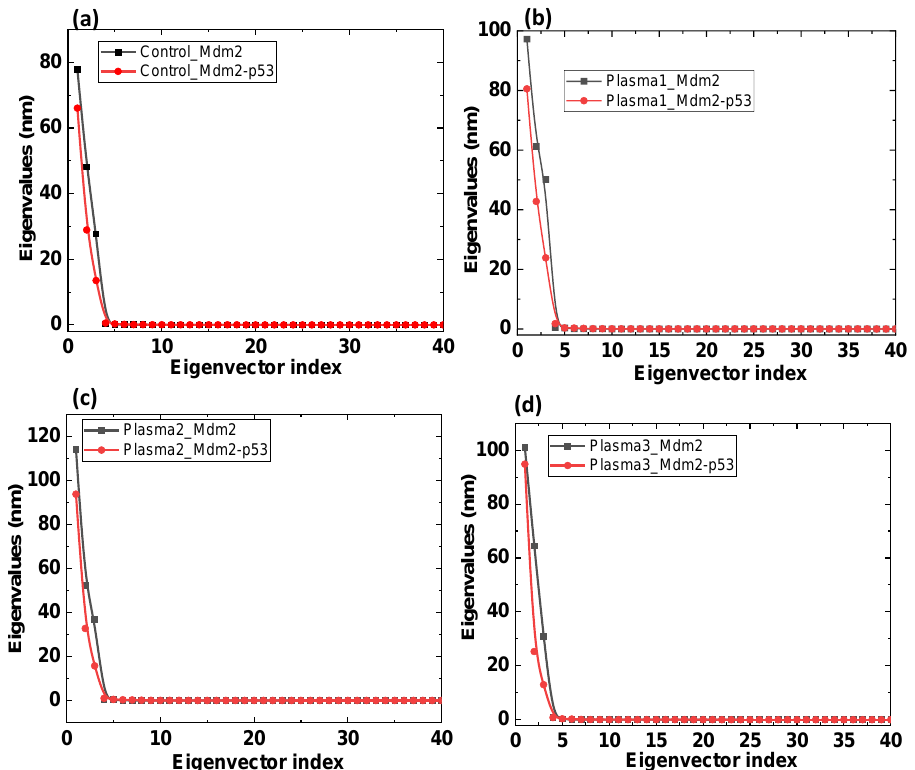
Figure 6. Comparison of the eigenvalues plotted against the corresponding eigenvector indices obtained from the C α covariance matrix for ( a ) control Mdm2 and Mdm2–p53 complex, ( b ) plasma1 Mdm2 and Mdm2–p53 complex, ( c ) plasma2 Mdm2 and Mdm2–p53 complex, and ( d ) plasma3 Mdm2 and Mdm2–p53 complex.